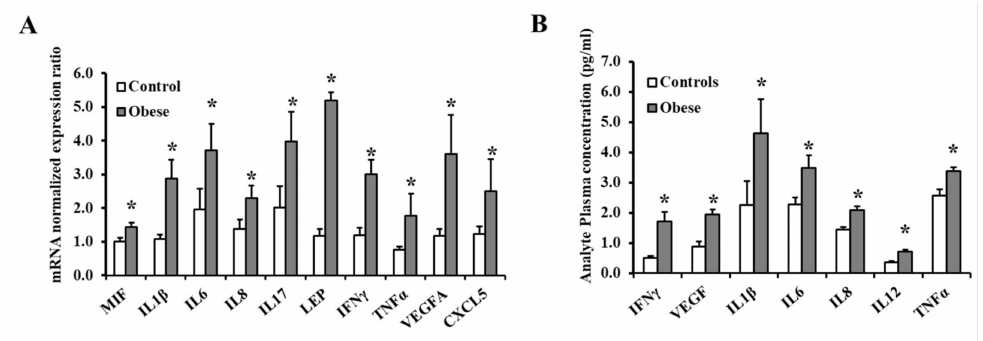
Figure 5. The expression of differentially methylated genes in VAT and circulation. ( A ) Quantitative assessment of the mRNA levels of 10 differentially expressed adipokines in VAT samples (60 obese and 60 controls) using real-time PCR. ( B ) Circulating concentrations of inflammatory cytokines measured in obese subjects ( n = 60) and non-obese controls ( n = 60) using specific ELISA assays. Results are shown as means ± standard error (SE), and the * symbol reflects a p -value < 0.05 when comparing obese subjects with controls.